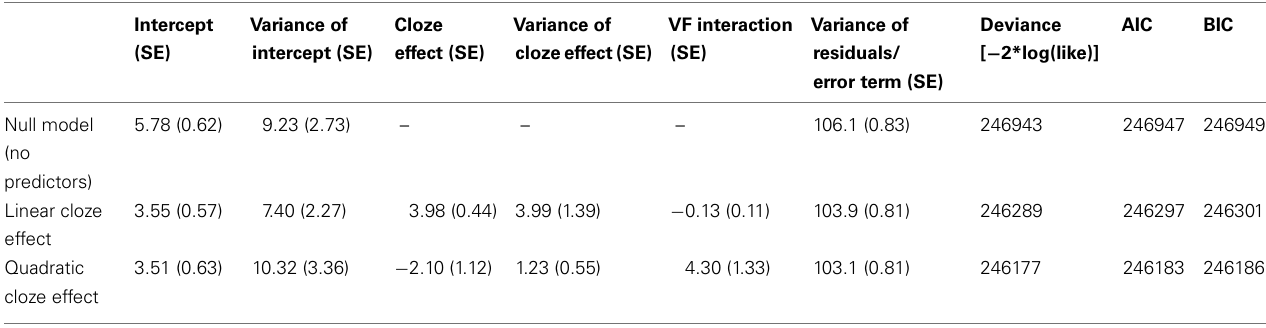
Table 2 | Relevant HLM parameters and fit statistics for N400 data predicted by cloze probability as given by SAS PROC MIXED.